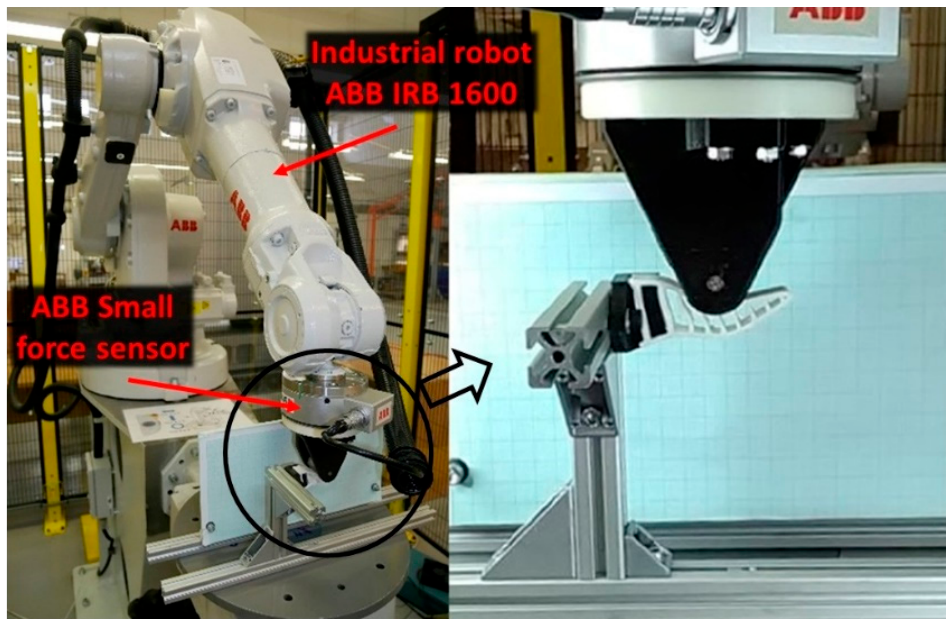
Figure 8. Testing device. Left: entire device, right: detail under load.